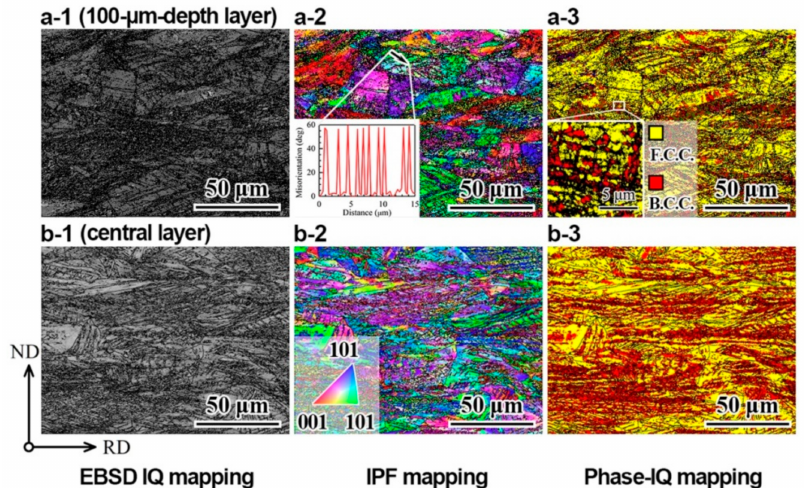
Figure 6. EBSD images of the GS2 sample after tensile testing at room temperature: ( a1 – a3 ) IQ, IPF and phase mappings for the layer with a depth of 100 µ m; ( b1 – b3 ) IQ, IPF and phase mappings for the central layer.